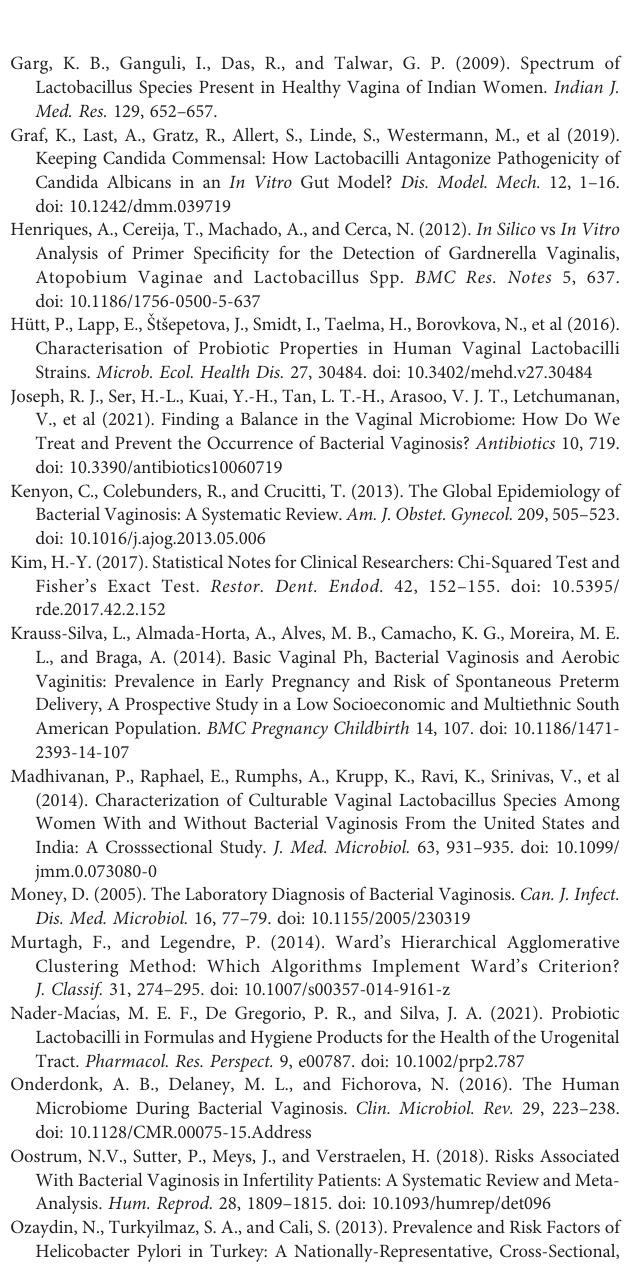
tests wereperformed to evaluate the absence or presence ofeach pathogen during the presence of each cluster, showing the P -values with statistically signi fi cant differences as bold